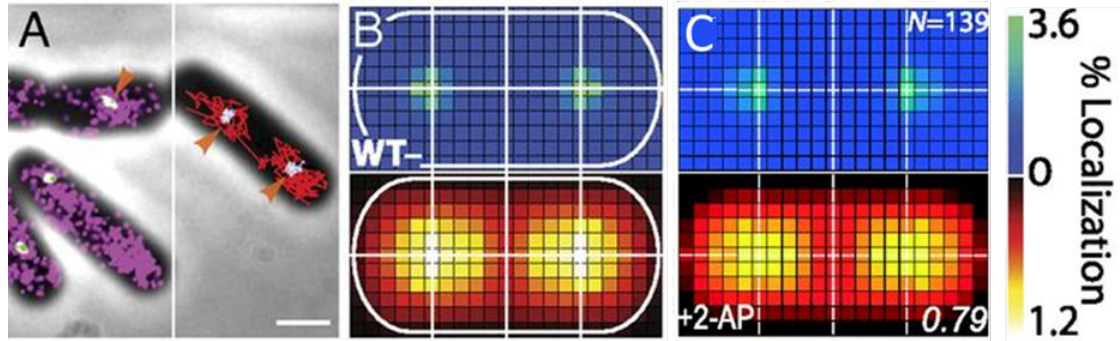
FIGURE 3: MutS localizations and co-localizations in B. subtilis cells. (A) Photoactivated localization microscopy (PALM) reconstruction (left; magenta) and single-molecule trajectories (right; red) of MutS-PAmCherry overlaid with DnaX-mCitrine (green and blue) and phase- contrast cell images. Overlapping signals are in white and orange arrows indicate replisome regions at which MutS enrichment is observed. (Scale bar: 1 μ m). (B) Localization probability density maps of DnaX-mCitrine (upper; blue-green) and MutS-PAmCherry (lower; red-yellow) within a normalized cell. (C) Normalized cell maps as in (B) but for the MutS[F30A] mutant shows that the localization of MutS to the repli- some is independent of the ability of MutS to identify mismatches. Reproduced from Liao et al. PNAS 2015